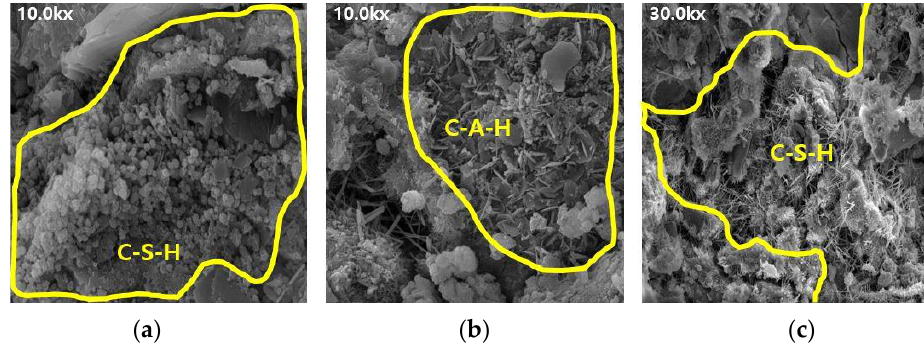
Figure 6. SEM results of ABFS25: ( a ) 3 d, ( b ) 7 d, and ( c ) 28 d.